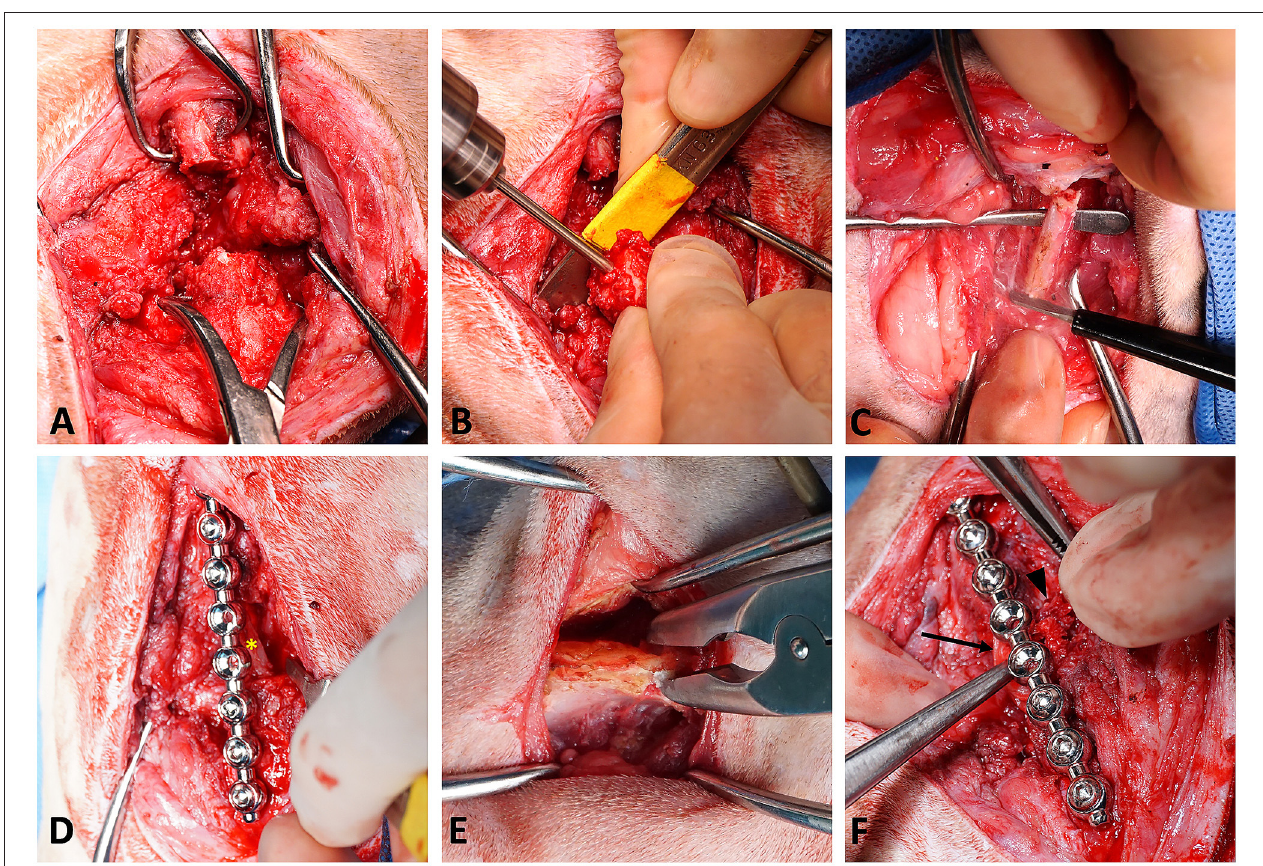
FIGURE 3 | Surgical procedures. (A) Debridement of the diaphyseal fracture site of the right femur using a harmonic scalpel. (B) Medullary recanalization using a 2.8-mm pin. (C) Autograft harvested from the ipsilateral seventh rib. (D) Fixation using a locking plate system followed by transplantation of the autologous rib; the asterisk indicates the rib autograft. (E) Autograft harvested from the ipsilateral iliac crest. (F) Application of the rhBMP-2-soaked collagen sponge onto the site of defect; the arrow indicates the soaked sponge surrounding the bone defect, and the arrowhead indicates the corticocancellous iliac